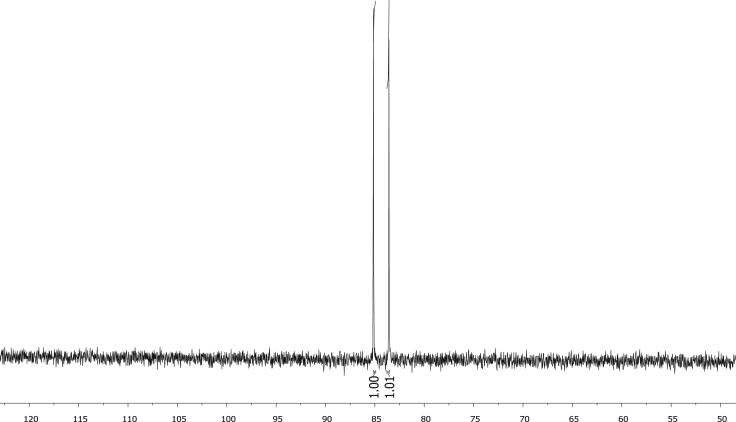
31P NMR of [Rh(acac)CO(C6H4SPPh2)], 5.